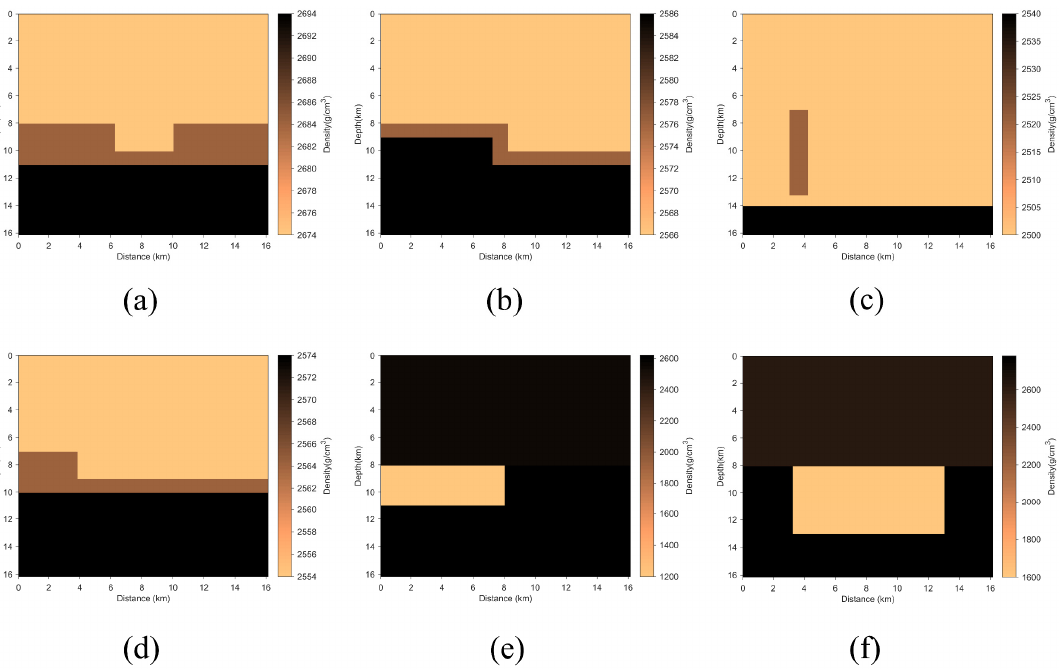
Figure 3. The density parameters of six geological models ( a – f ) for the training data set: ( a ) Graben model, ( b ) pleated–structure model, ( c ) magmatic intrusion model, ( d ) platform model, ( e ) magmatic intrusion model, ( f ) magmatic intrusion model.